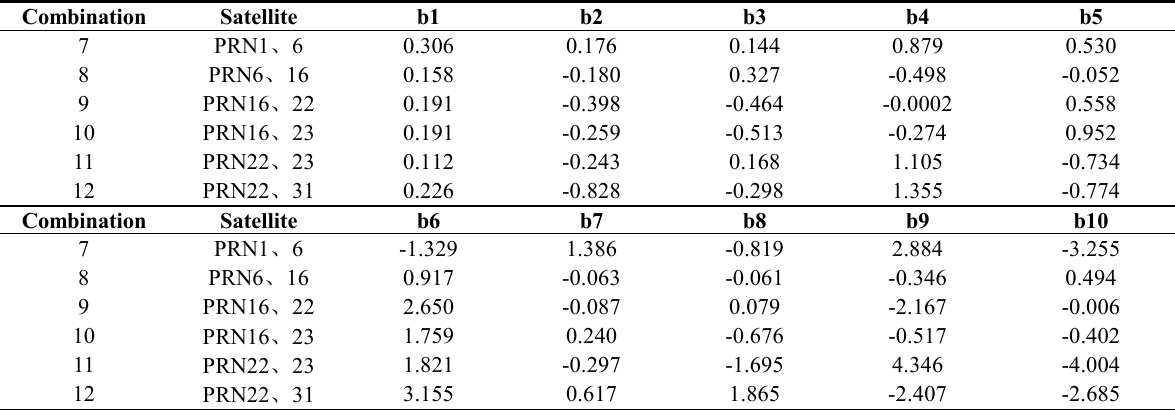
Tab. 2 Double star nonlinear regression model regression coefficient